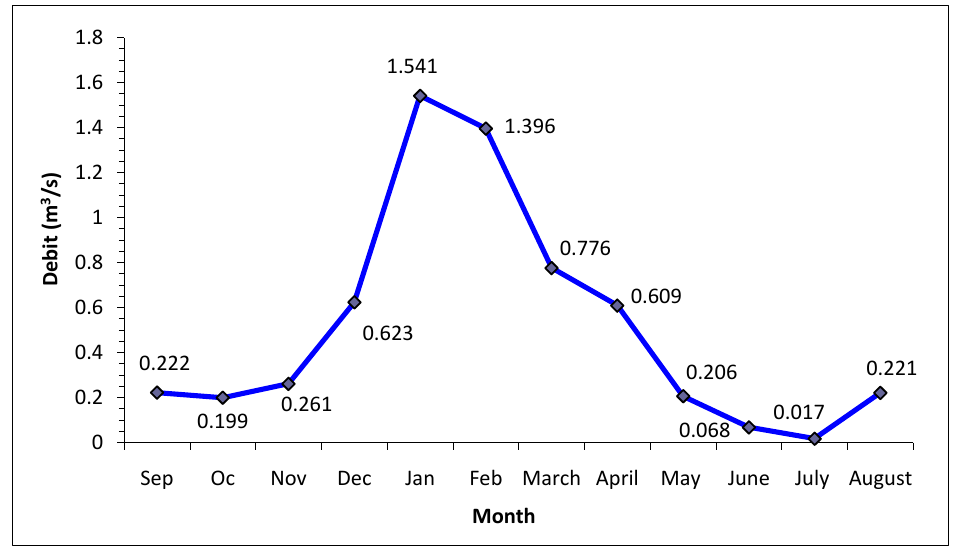
Figure 30. Average monthly debits,